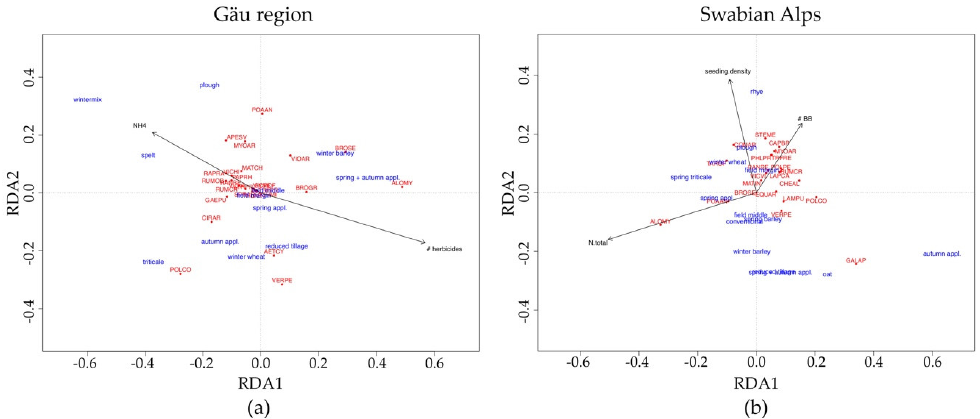
Figure 4. Ordination diagram of the partial redundancy analysis (RDA) from ( a ) the Gäu region and ( b ) the Swabian Alps containing ( a ) six and ( b ) eight significant explanatory variables. Only species with the highest fit on the first two axes are displayed. Eigenvalues for ( a ) the Gäu region are 0.083 for RDA1 and 0.058 for RDA2 with total inertia of 0.703 and 0.299 for all constrained axes. Eigenvalues for the ( b ) Swabian Alps are 0.057 for RDA1 and 0.045 for RDA2 with total inertia of 0.689 and 0.321 for all constrained axes. Abbreviation of weed species according to the EPPO Code.